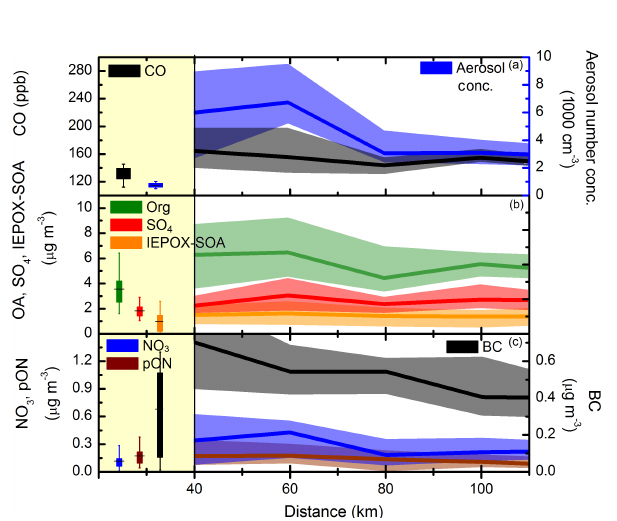
Figure 6. Regional background (marked in yellow) and in-plume concentrations for CO and aerosol concentration (a) ; OA, SO 4 and IEPOX–SOA (b) ; and NO 3 , p ON, and BC (c) . The boxplot is the interquartile and vertical lines the 10th and 90th percentiles. The plume data show median values (line) and interquartile (shaded area) for 20km distance